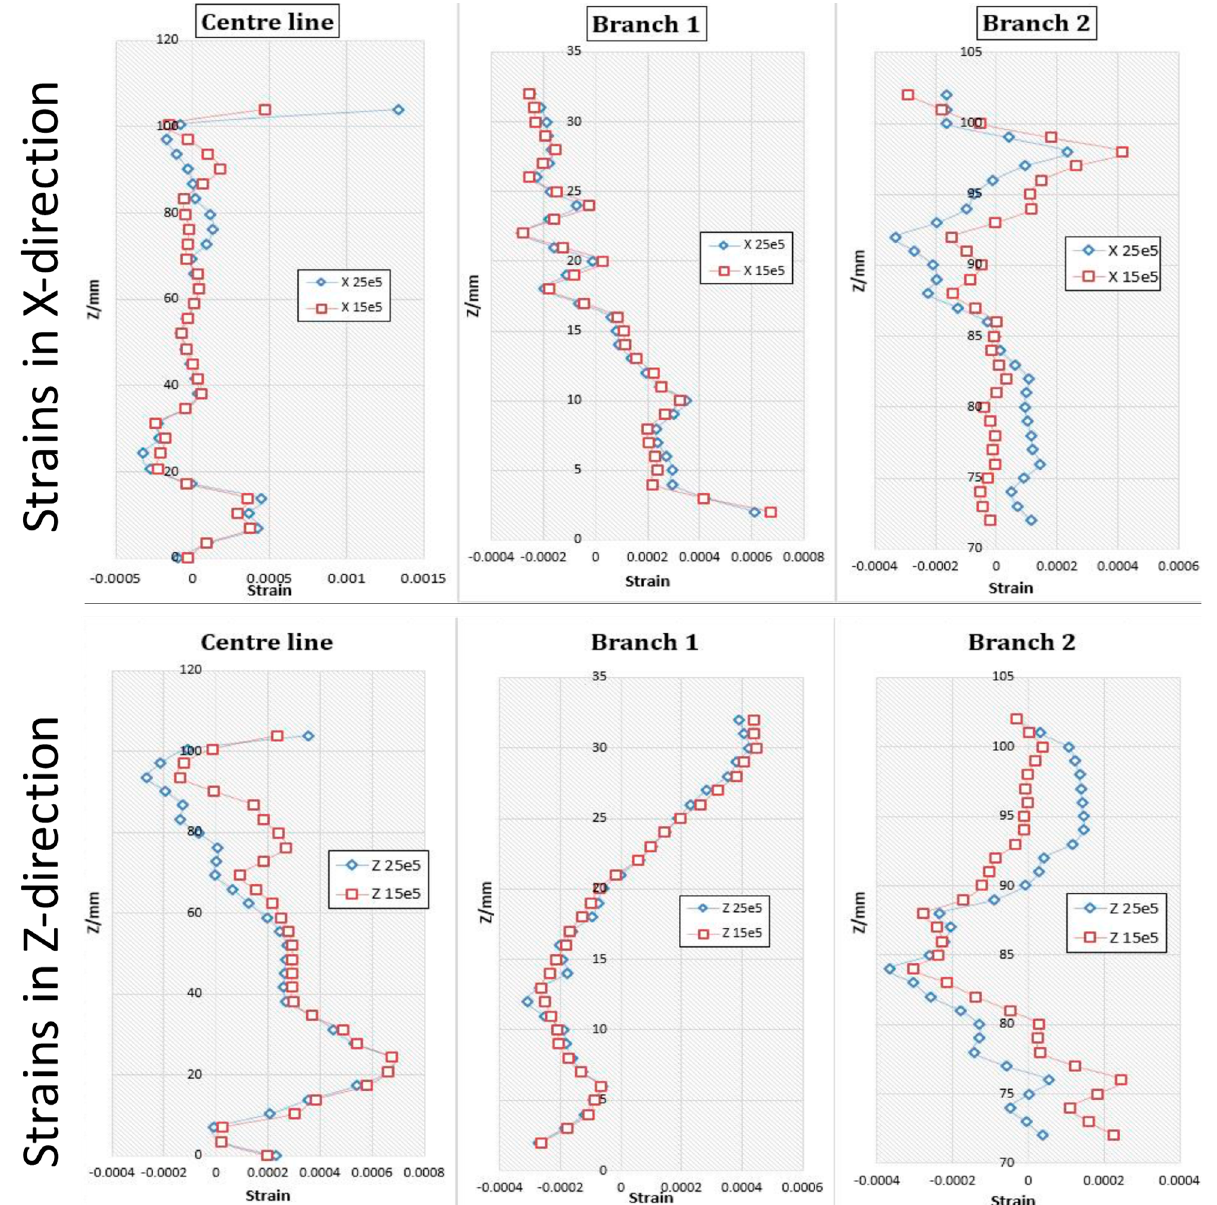
Figure 8. Residual strains calculated through FEA.